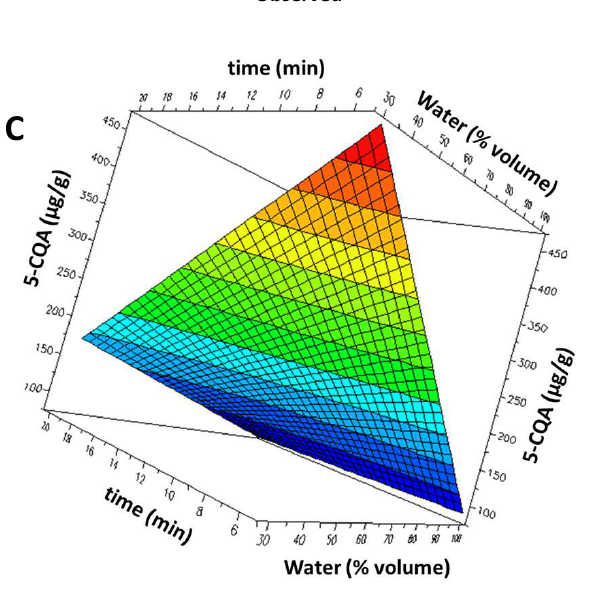
Figure 2. Results of the experimental design: ( A ) coefficient plot, ( B ) observed vs. predicted plot, ( C ) response